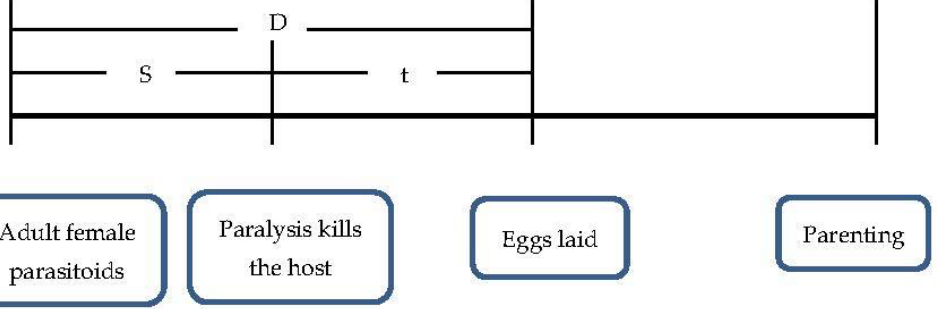
Figure A2. “ S. guani-B. bassiana-M. alternatus ” coexist in space, showing the hyphae of the B. bassiana grow rate. (a–f: growth of hyphae at 10 4 conidia mL − 1 B. bassiana suspension; g–l: growth of hyphae at 10 5 conidia mL − 1 B. bassiana suspension; m–r: growth of hyphae at 10 6 conidia mL − 1 B. bassiana suspension).